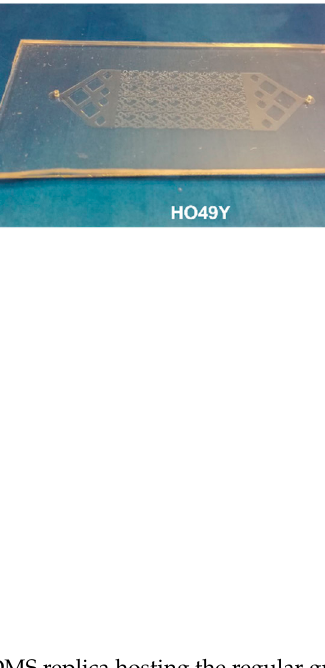
Figure 9. A FESEM image of a cross section of the PDMS replica hosting the regular grid.